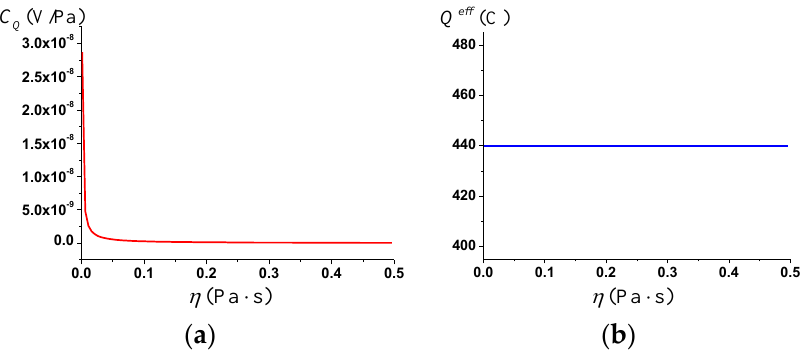
Figure 4. Effect of water viscosity (steady case): ( a ) streaming potential coupling coefficient; ( b ) ef- fective net residual charge density. effective net residual charge density.